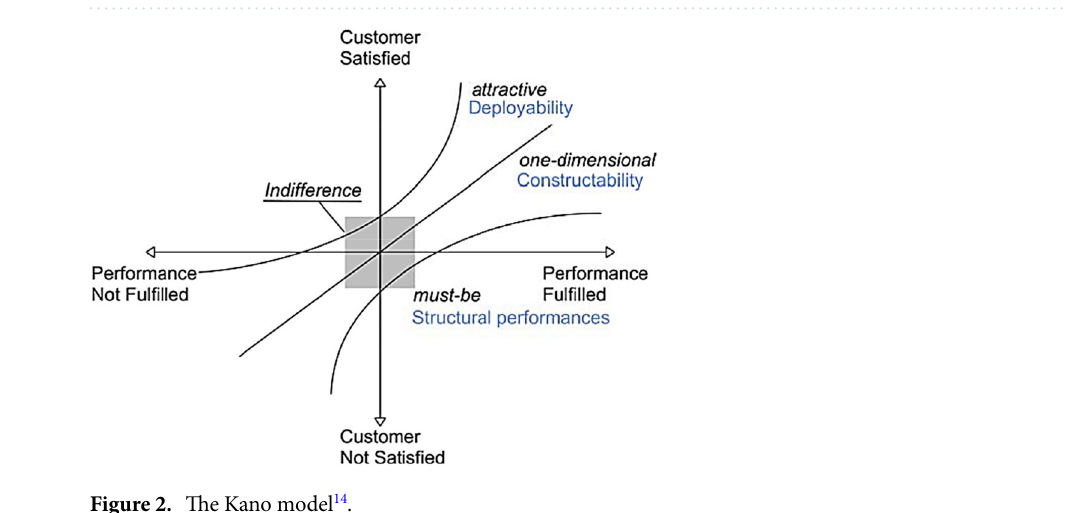
Figure 1. Example of ( a ) origami-inspired steel pavilion building prototype 9 and ( b ) typical modular building.